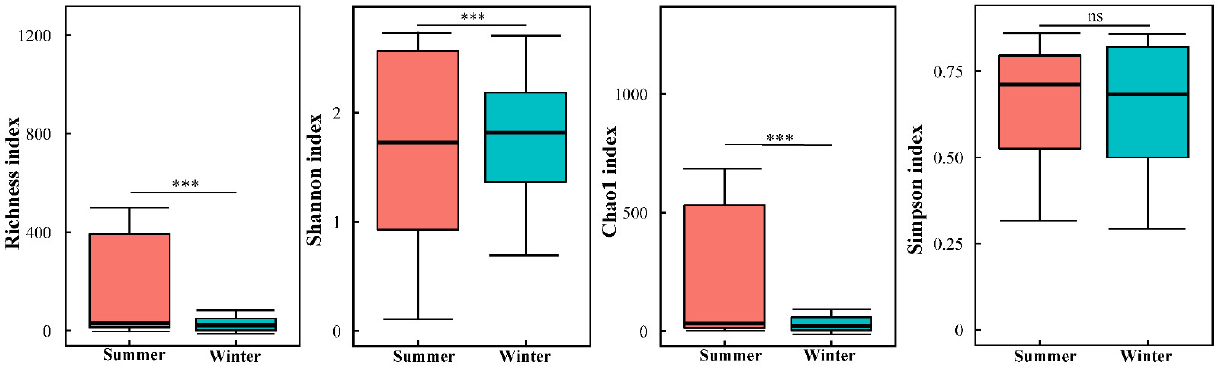
Figure 4. The α-diversity indexes including richness, Shannon, Chao1, and Simpson for two season groups. The differences between pairs of two groups were tested by the Wilcoxon test. ns, not significant. *** : p < 0.001.